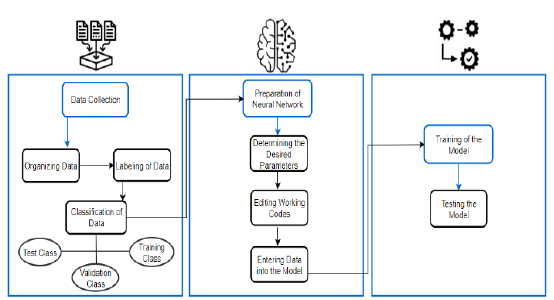
Figure 4 . The workflow of the study.